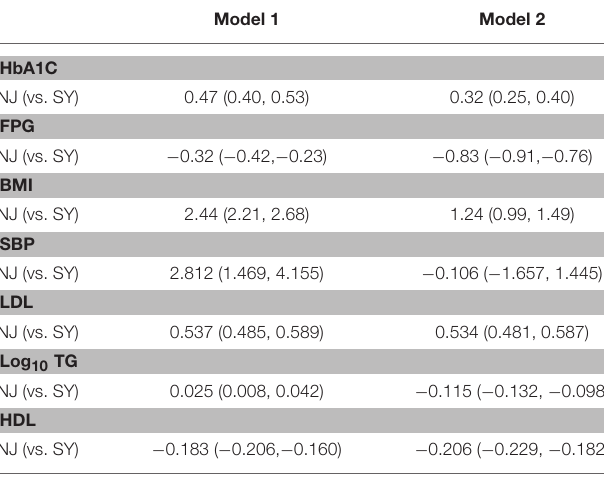
TABLE 4 | Liner regression analysis of metabolic indexs in NJ compared to SY. Model